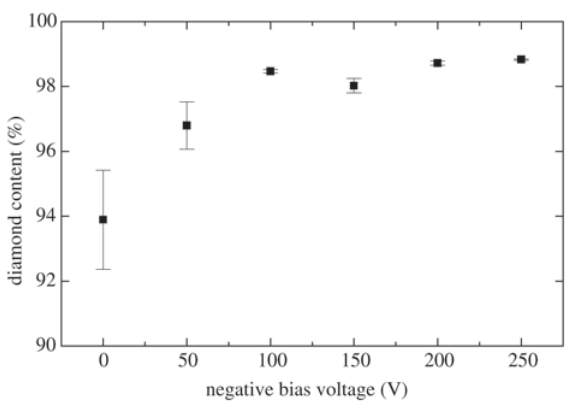
Figure 4. The Raman spectra of diamond coatings at different ap- plied bias voltages: (a) –50; (b) –150; (c) –250 V.